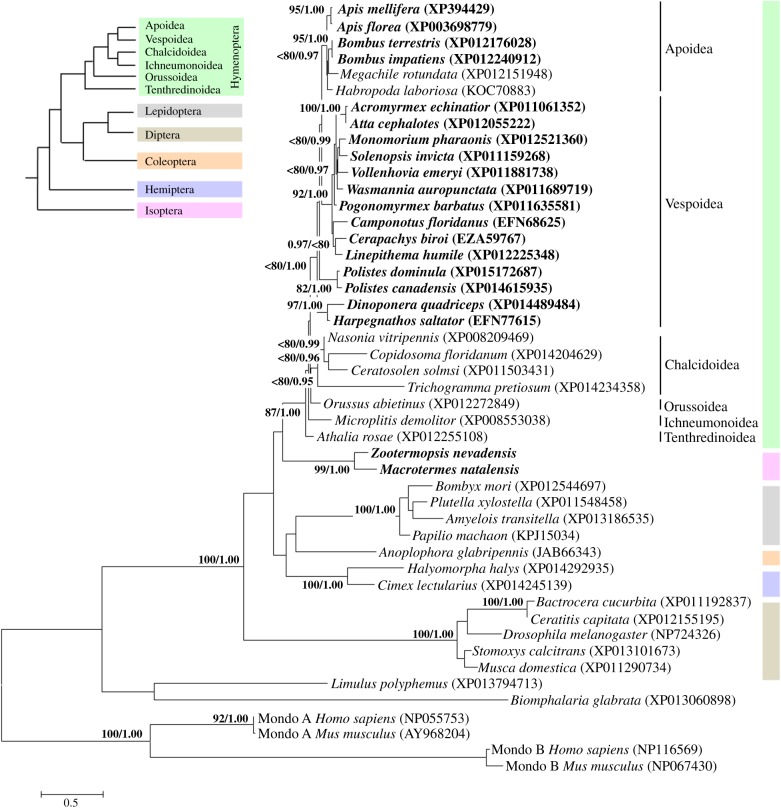
Fifty per cent majority rule consensus tree obtained from the ML analyses of ChREBP amino acid sequences (GSM region, 331 amino acids). ML bootstrap values > 80% and Bayesian posterior probabilities > 0.95 are plotted on the nodes. Tree is rooted on vertebrate Mondo A and Mondo B (ChREBP) sequences. Social species are indicated in bold. Upper-left corner: insect phylogeny adapted from Mao et al. [33] and Misof et al. [34].